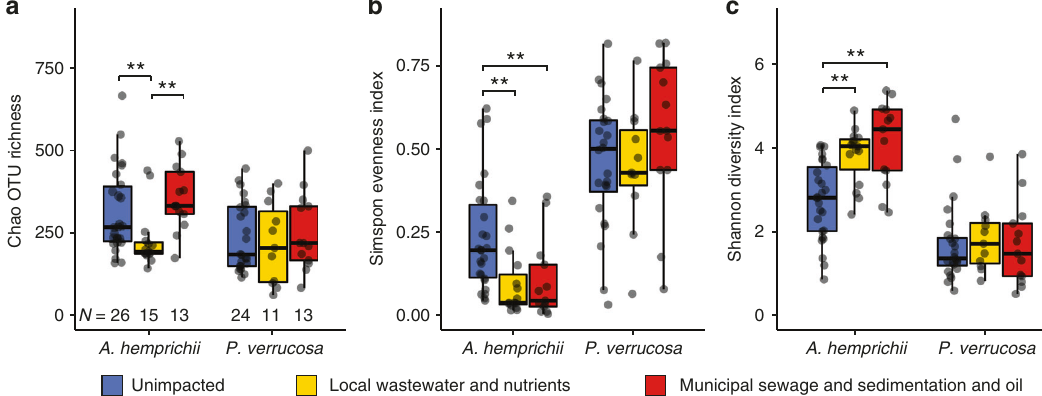
Fig. 5 Bacterial diversity of the corals A . hemprichii and P . verrucosa across impacts. Samples were collected after 21 months of reciprocal transplantation across different impacts ( “ Unimpacted ” , “ Local wastewater and nutrients ” , “ Municipal sewage and sedimentation and oil ” ) near Jeddah, Red Sea and are displayed by destination impact. a Chao Index of bacterial richness, b Simpson Index of bacterial community evenness, c Shannon Index of bacterial diversity. Boxes of box plots represent the 25th to 75th percentile, lines show medians, error bars represent smallest/largest values to a maximum of 1.5 * IQR. N of each group indicated in a , Kruskal – Wallis tests signi fi cance level: ** p < 0.01. Source data are provided as a Source Data fi